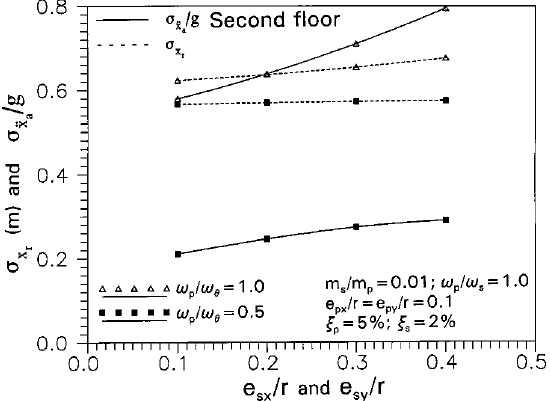
=g with (cid:24) s ; for second floor and (cid:27) (cid:127) x r a